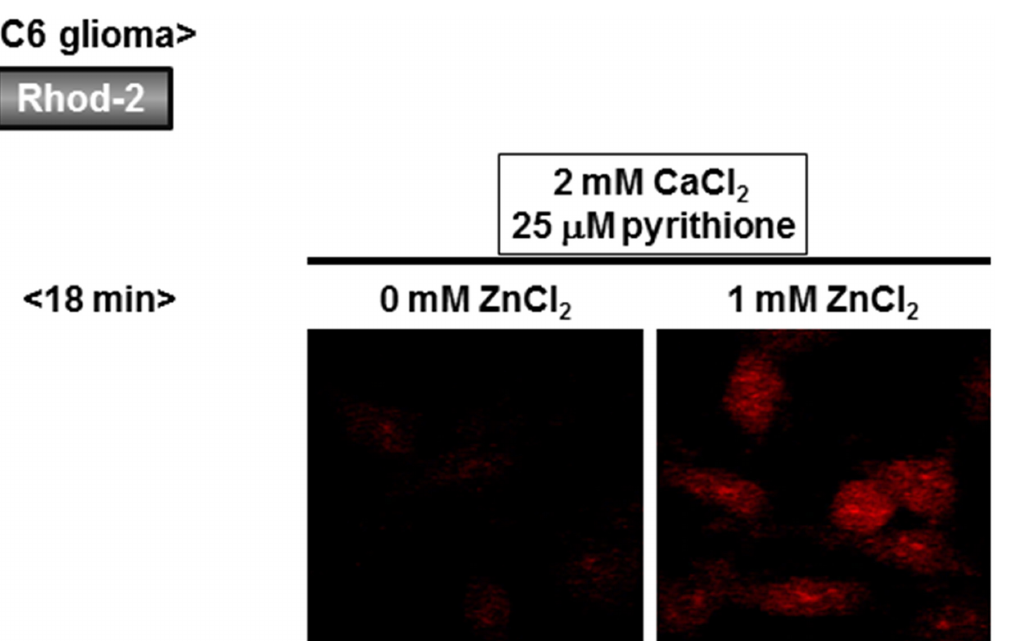
Fig 6. Micrographic pictures of Rhod-2 fluorescence in C6 glioma cells exposed to CaCl 2 and ZnCl 2 in the presence of pyrithione. Typical pictures are shown here.